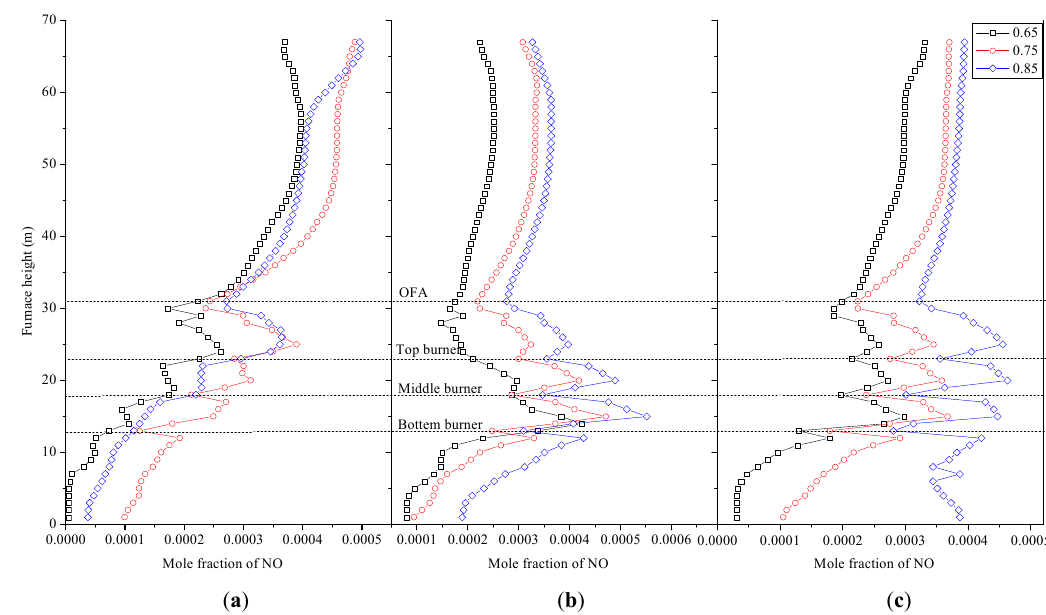
Figure 11. The mole fraction of NO along the height of furnace; ( a ) in-furnace-down; ( b ) in-furnace-up; ( c ) out-furnace.